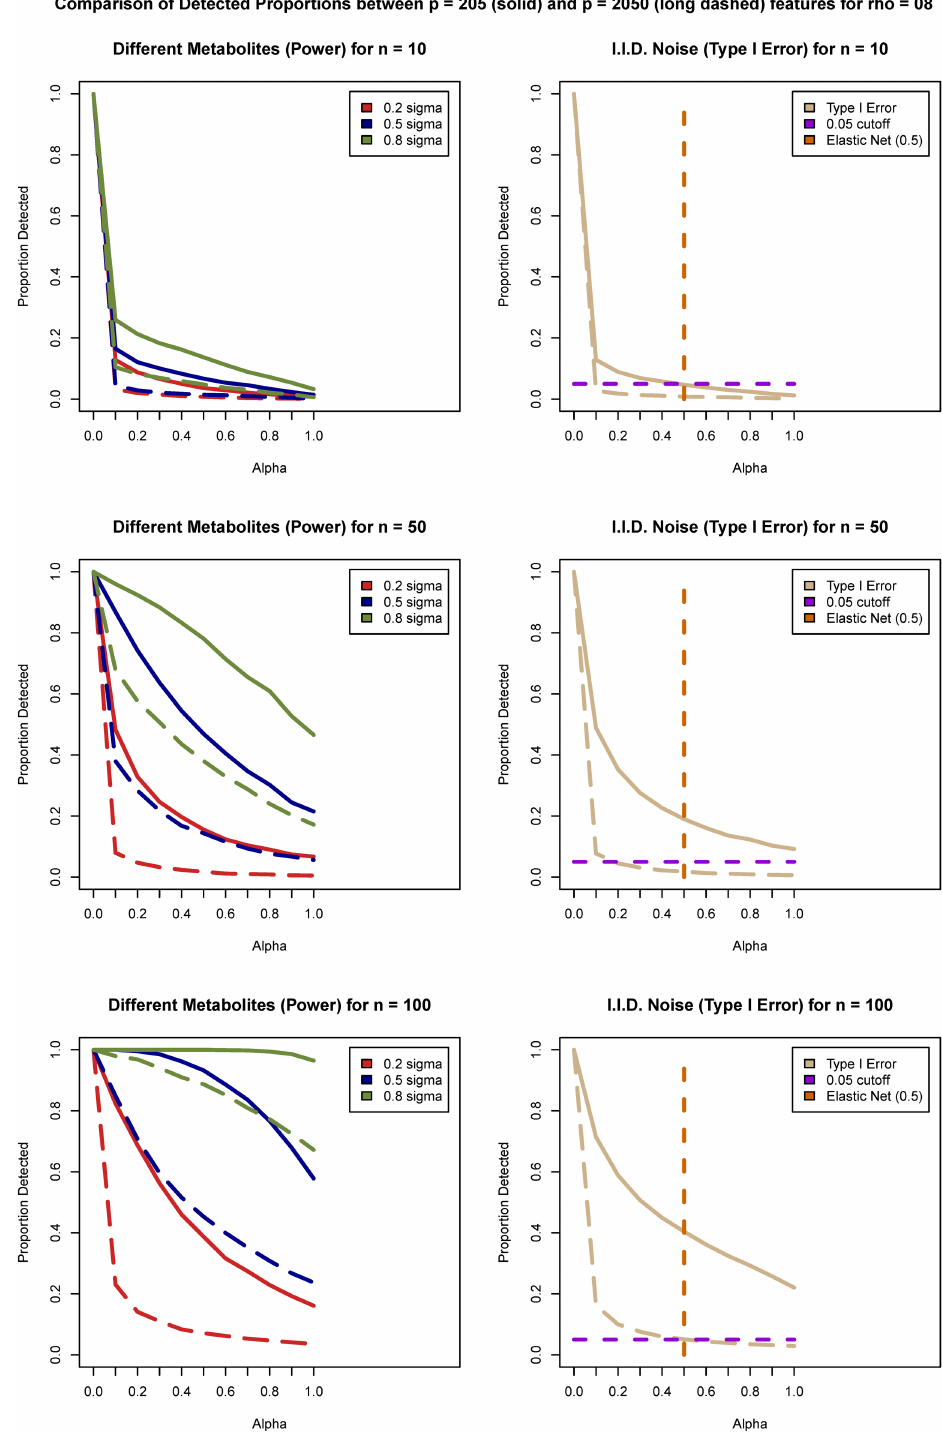
Fig 3. Visualization of power and Type I error estimates comparison for p = 205 features, correlation ρ = 0.4, and all sample sizes. Each row of the plots corresponds to a feature selection method. ANOVA FDR adjustment cutoff is 0.2. The value of the sample size ( n ) is displayed on the x -axis in all plots. The estimates of power and Type I error are provided on the y -axis. In the left column power estimates are provided based on the four different features for each of the effect sizes ( Δ 1 = 0.2 is the red line, Δ 2 = 0.5 is the blue line, and Δ 3 = 0.8 is the green line). In the right column Type I error estimates are provided (beige lines) based on the random noise features together with a 0.05 threshold plotted as